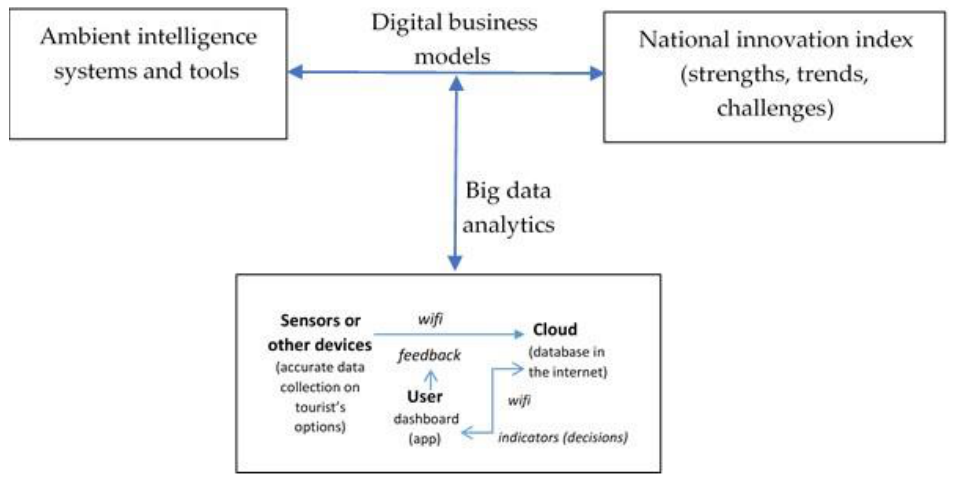
Figure 7. A framework for managing assertive digital business models.